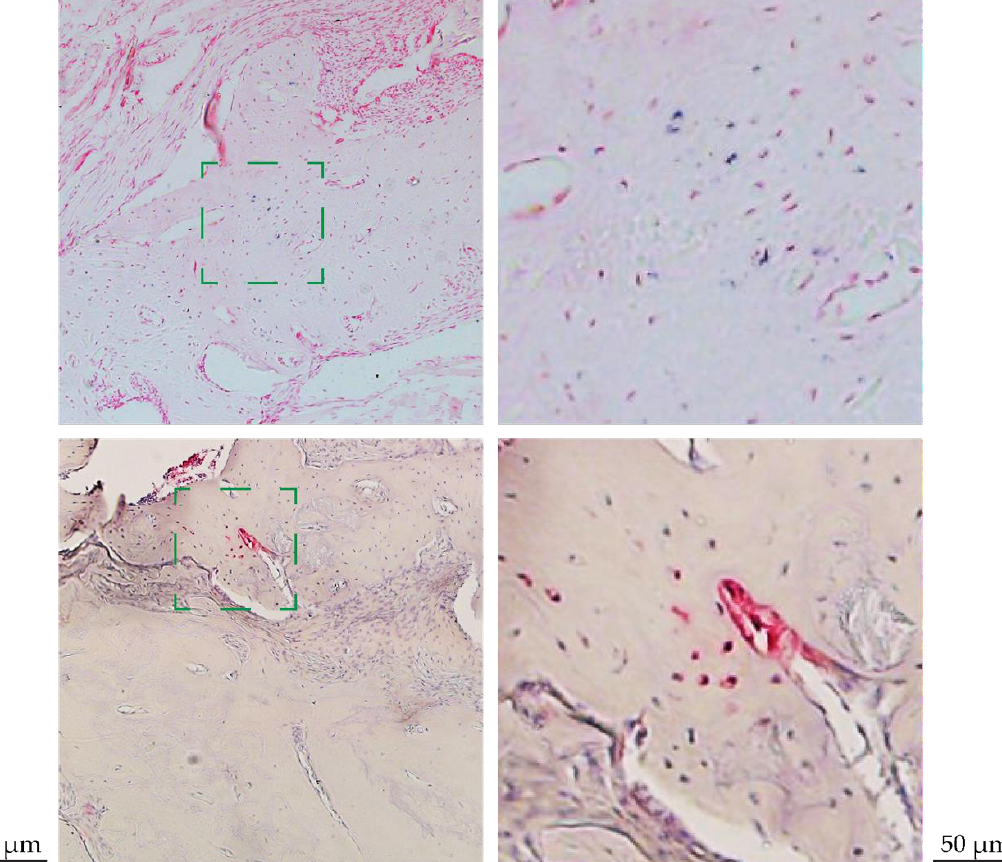
Figure 12. Histological analyses of the injected stem cells (hMSC). Histological sections allowed for identifying implanted hMSC by using in situ hybridization of the repetitive human specific Alu sequences, see images in the top row. Human cells possess a blue color clearly seen in the enlarged view on the right. Immunostaining for HLA-1 (bottom row) shows human osteocytes, indicated by the red color. They are part of the newly formed bone.